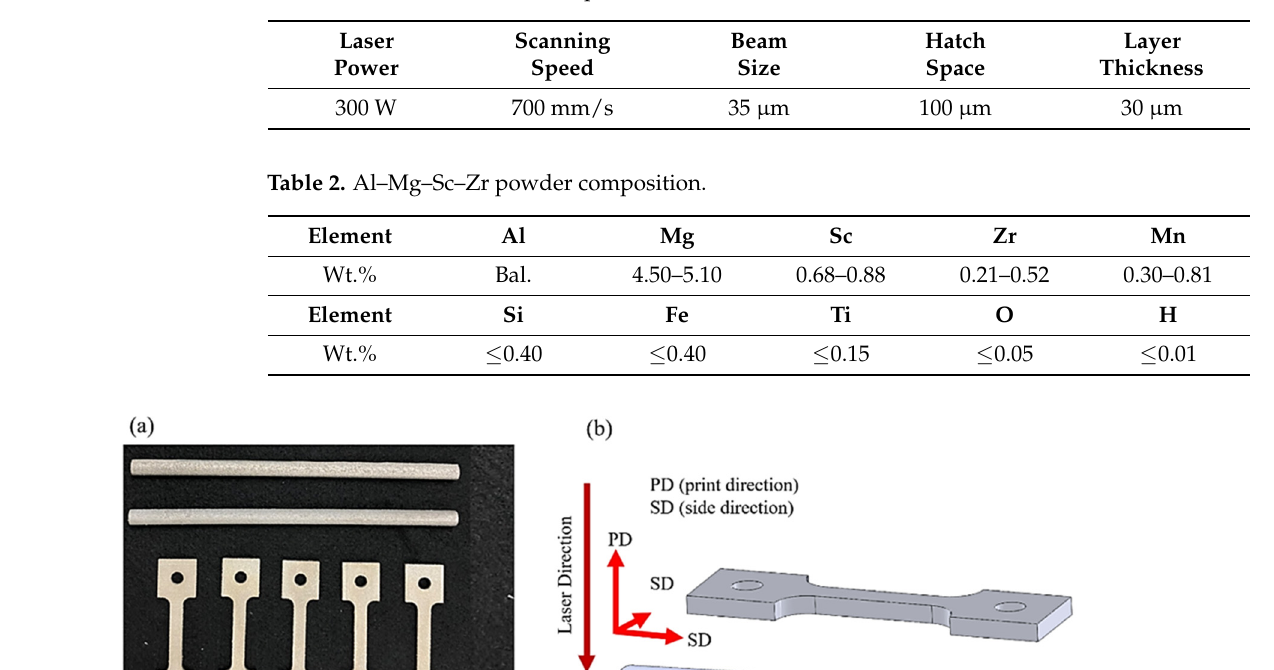
Table 2. Al–Mg–Sc–Zr powder composition.